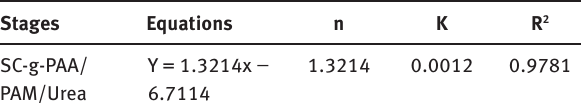
Table 5: Release kinetic parameters of SC-g-PAA/PAM/Urea in water.